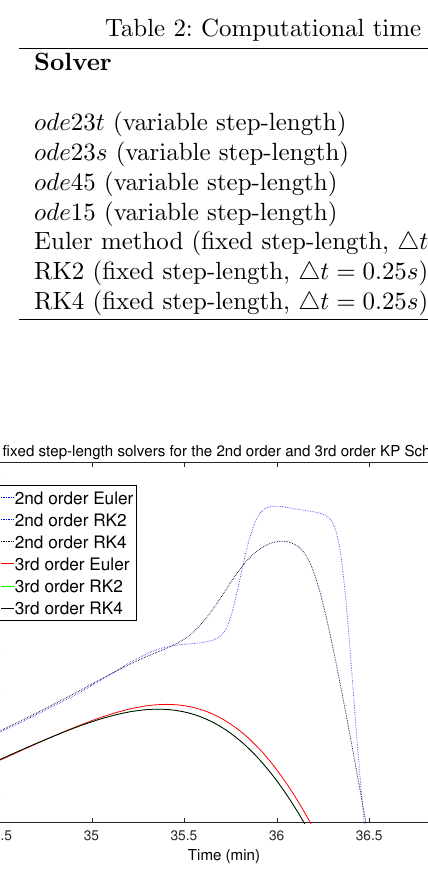
Figure 10: ode23s for 2 nd and 3 rd order KP scheme.